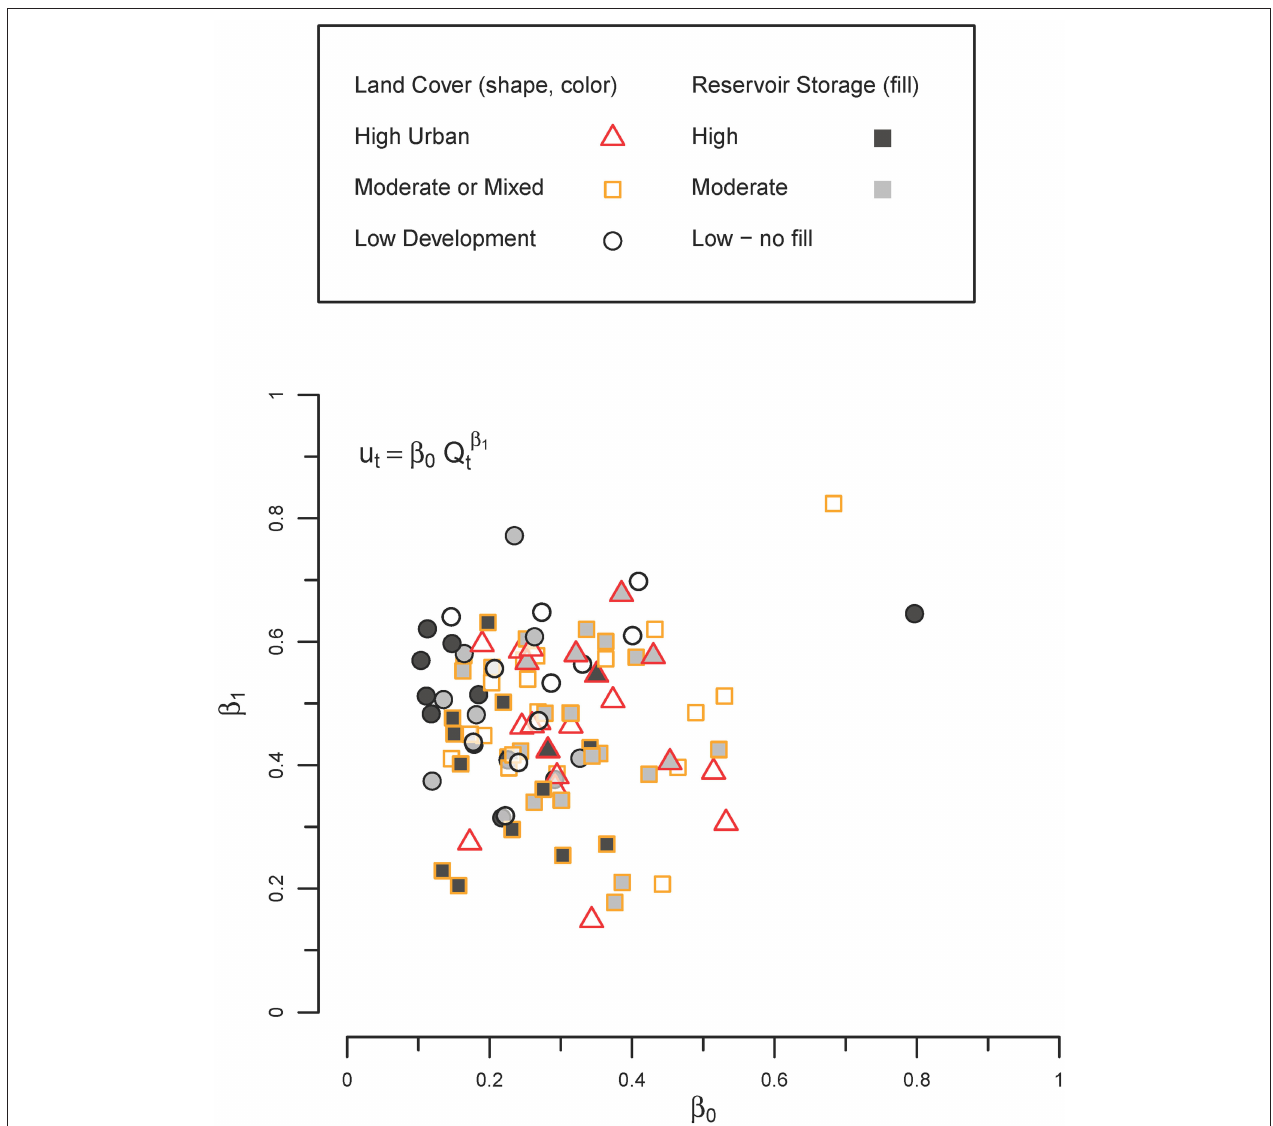
FIGURE 2 | Velocity function (Equation 5) parameters for 100 streams in the southeastern US.